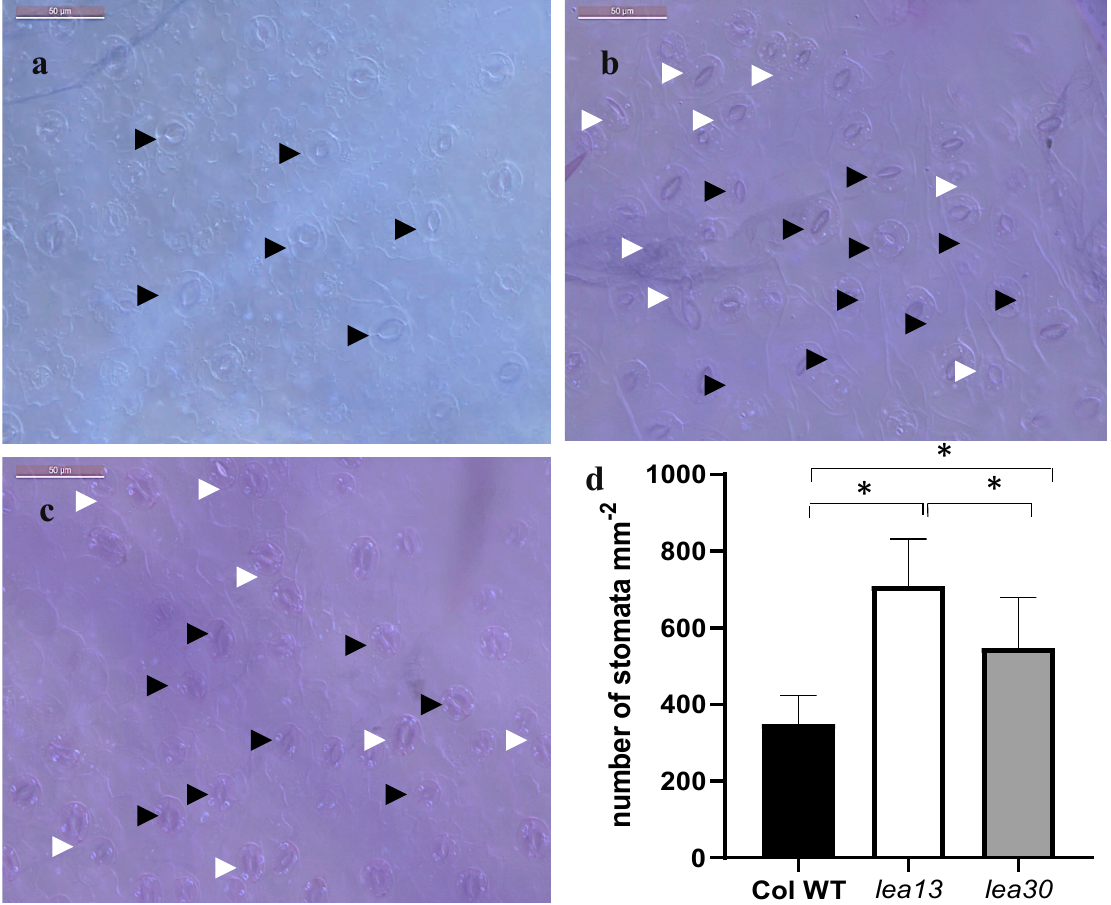
Figure 5. Stomatal density in lea13 , lea30 , and wild-type plants ( a – c ). Adaxial sides of cotyledons. Bar, 50 µ m. ( a ) Wild-type. ( b ) lea13 . ( c ) lea30 . ( d ) Stomatal density is shown as the average number of stomata per square millimeter. Black arrowheads point mature stomata. White arrowheads point stomata clusters. Bars indicate standard deviation. * Data represent samples Col WT and lea13 significantly different p <0.05. ** Data represent samples Col WT and lea30 significantly different p <0.05.